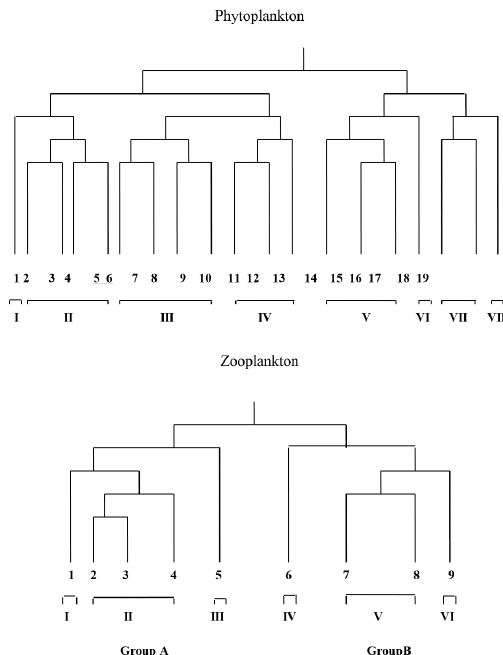
Figure 6. Diagrams of the different Nile plankton groups generated after the application of cluster